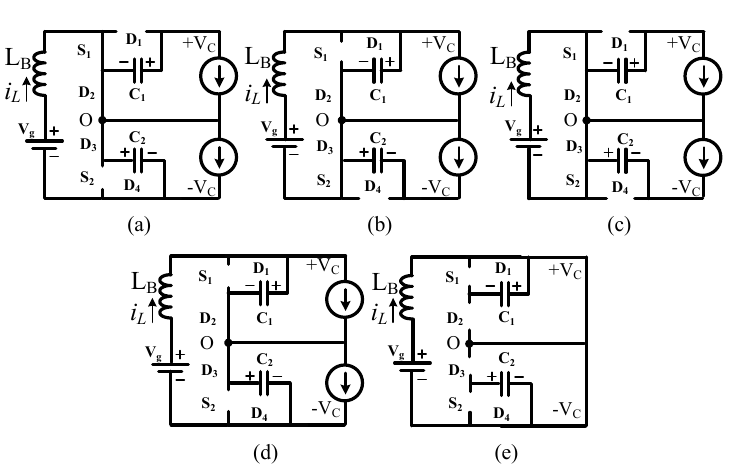
Figure 1. Topology of 3L qSBT 2 I.